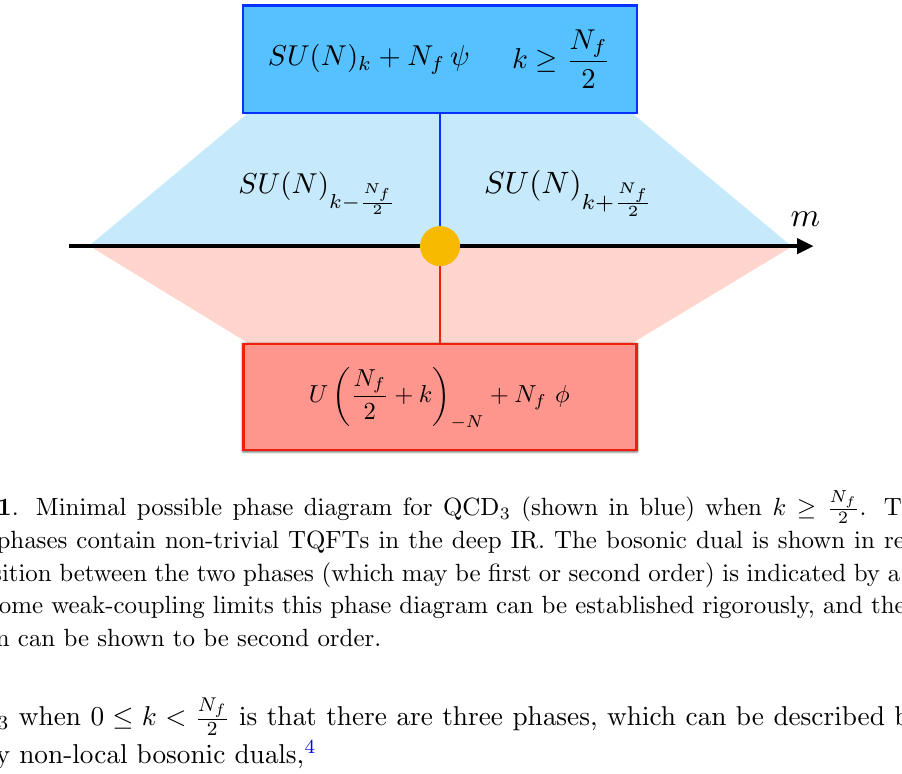
Figure 1 . Minimal possible phase diagram for QCD massive phases contain non-trivial TQFTs in the deep IR. The bosonic dual is shown in red, and the transition between the two phases (which may be (cid:12)rst or second order) is indicated by a yellow dot. In some weak-coupling limits this phase diagram can be established rigorously, and the phase transition can be shown to be second